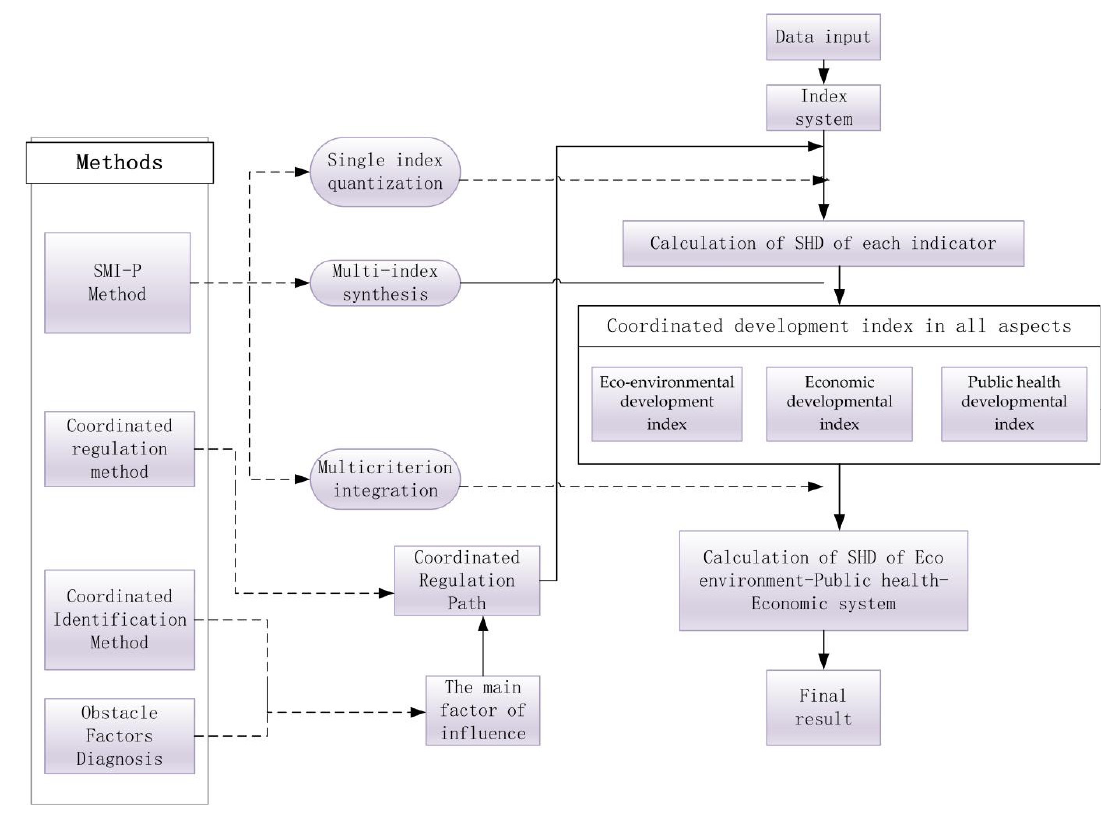
Figure 1. Research framework. Table 2. Quantitative index system for high-quality development of public health in the Yellow River